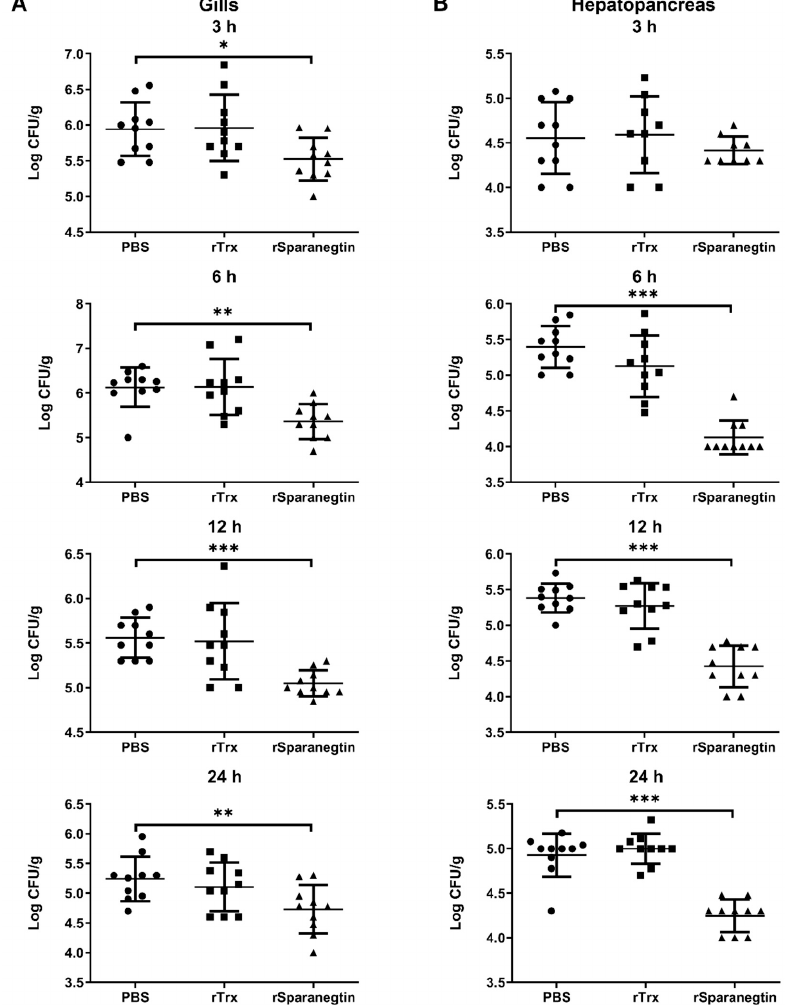
Figure 5. In vivo antimicrobial effect of rSparanegtin on V. alginolyticus growth in S. paramamosain. The rSparanegtin (20 μ g/crab), rTrx (20 μ g/crab), and PBS were incubated with V. alginolyticus (1 × 10 6 CFU/crab) at room temperature for 60 min and then injected into the base of the right fourth leg of crabs. Infected crabs were dissected, and tissues including gills ( A ), midgut, and hepatopancreas ( B ) were collected at different time points (3, 6, 12, and 24 h). Homogenates were cultured onto marine broth 2216E plates. Colony numbers were normalized to tissue weight. Data represent the bacterial load in gills, midgut, and hepatopancreas. * p < 0.05, ** p < 0.01; *** p <